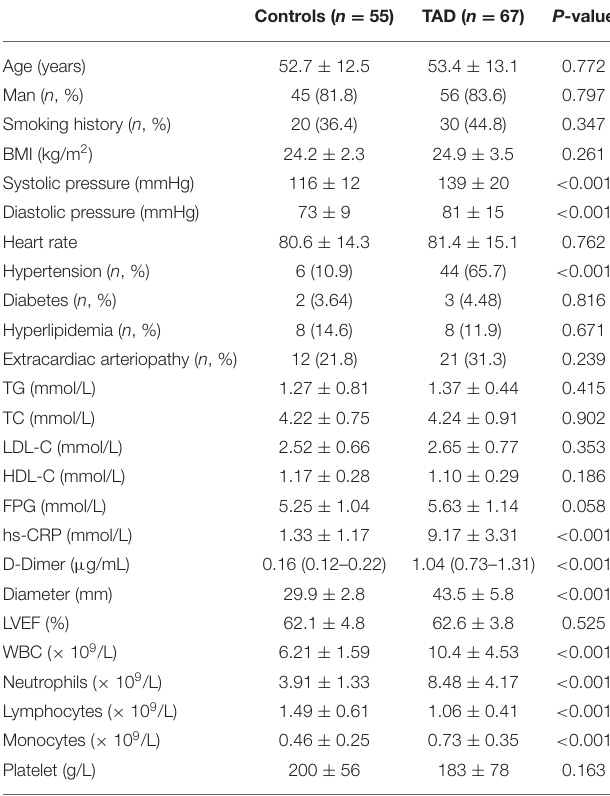
TABLE 2 | Clinical characteristics of patients provided blood